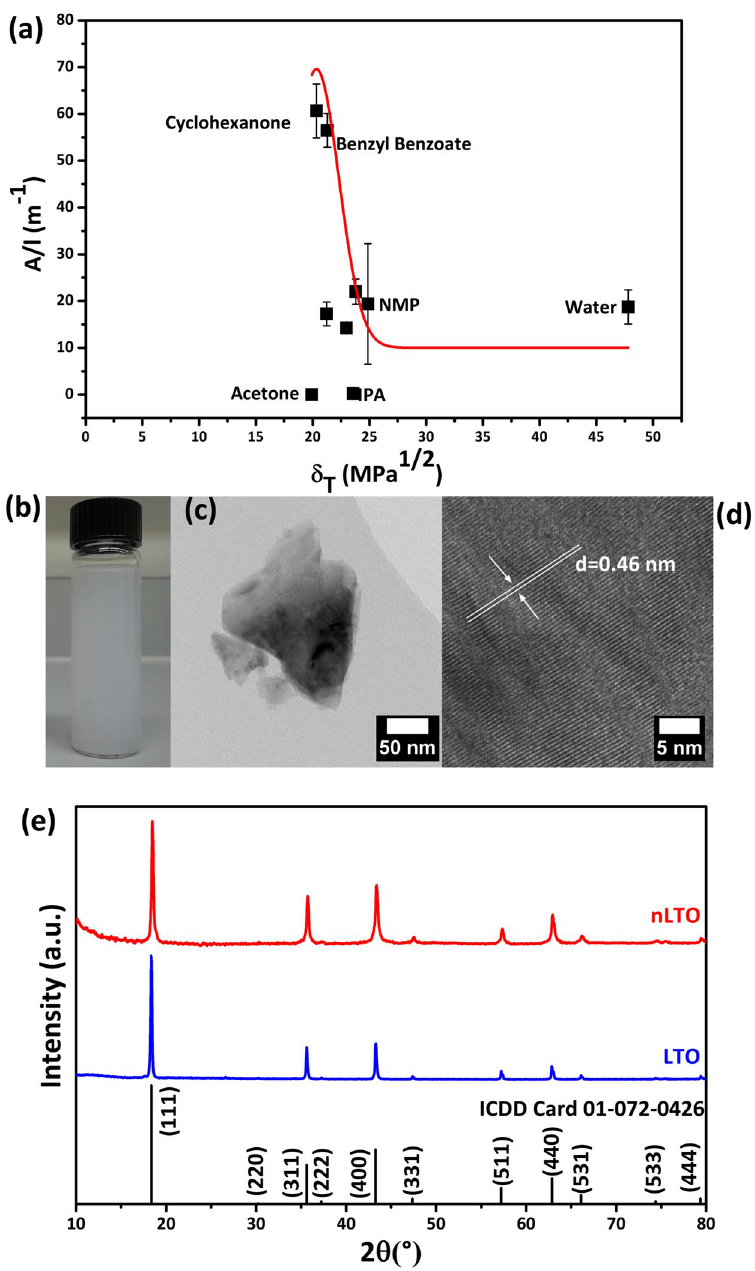
Figure 1. Absorption measurements of nLTO dispersions in a wide range of solvents plotted against solvent Hildebrand solubility parameter, δ T , ( a ); water based nLTO dispersion ( b ); representative TEM micrograph of a nLTO particle ( c ); high resolution TEM of a nLTO particle with corresponding interplanar spacing ( d ) and raw LTO and nLTO XRD pattern ( e